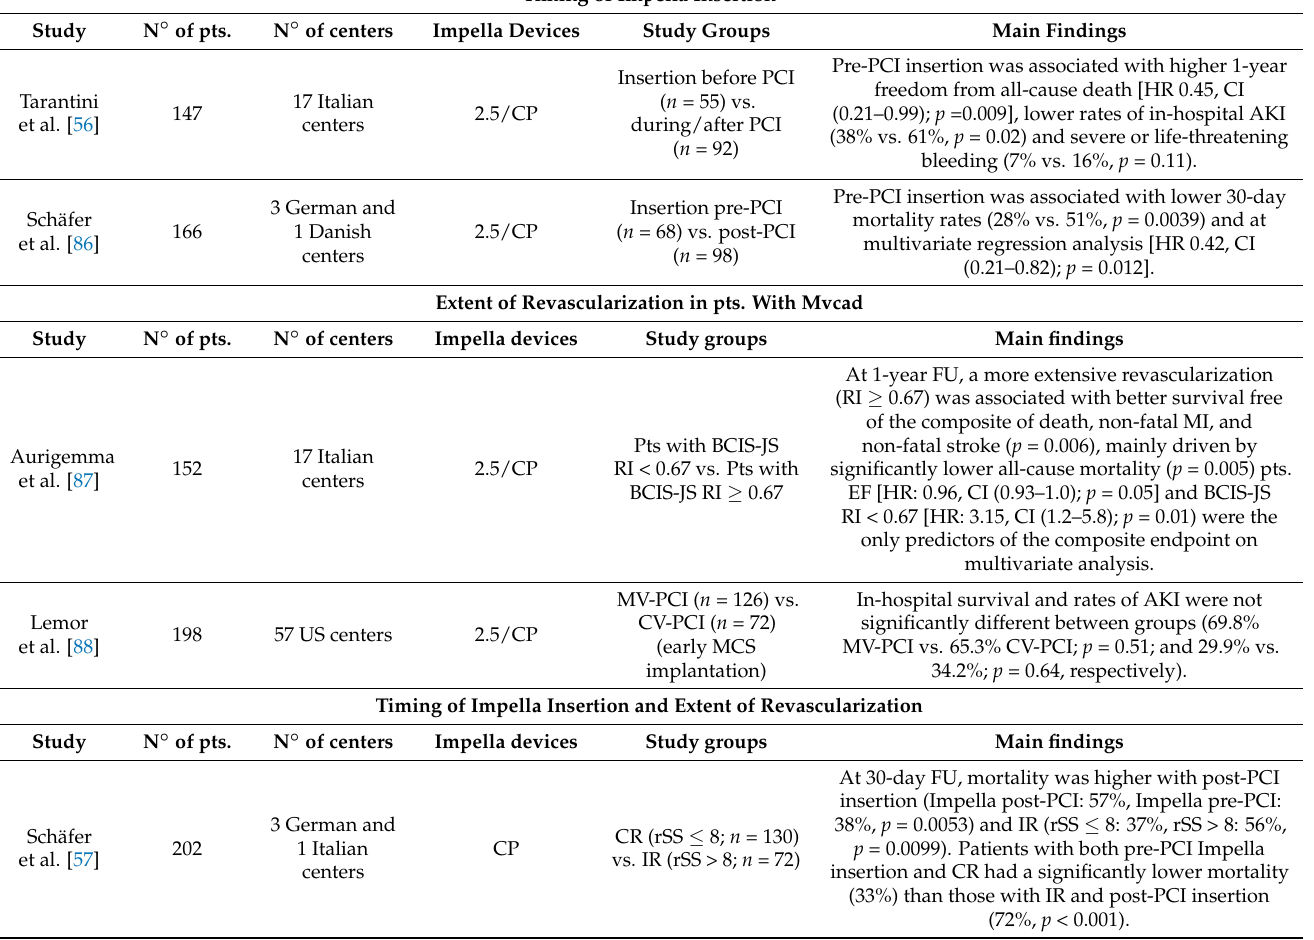
Table 4. Overview of the available studies investigating the impact of the timing of Impella 2.5/CP insertion and the extent of revascularization on outcomes in patients with AMI complicated by CS and treated with